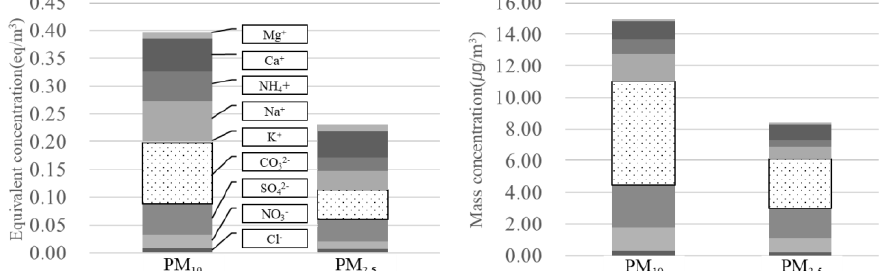
Figure 9. Normal and mass concentrations of ionic components in PM at the M station ( n = 13).